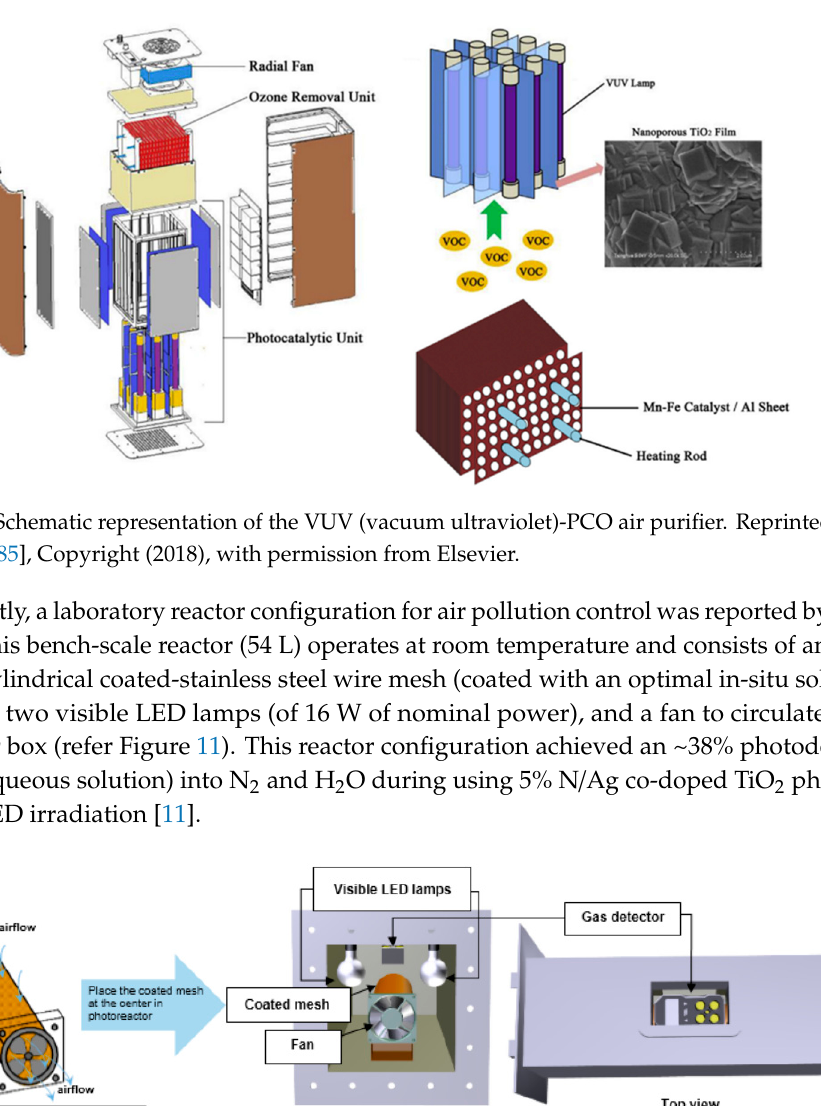
( b ) Figure 9. Schematic flow diagram of the customized experimental setup for: ( a ) NO degradation under visible light (adapted with permission from Reference [80], Copyright (2005), American Chemical Society), and ( b ) VOC removal under VUV (vacuum ultraviolet) irradiation (reprinted from [79], Copyright (2013), with permission of Elsevier).